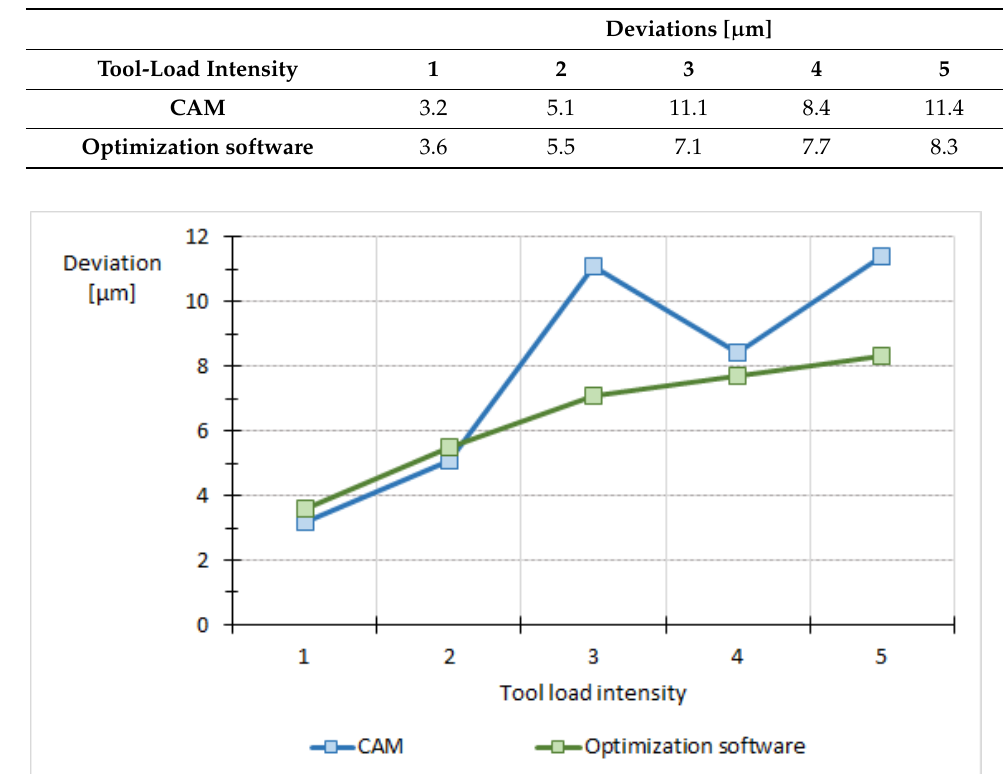
Table 7. Comparison of the maximum values of deviations at the bottom of the pockets.